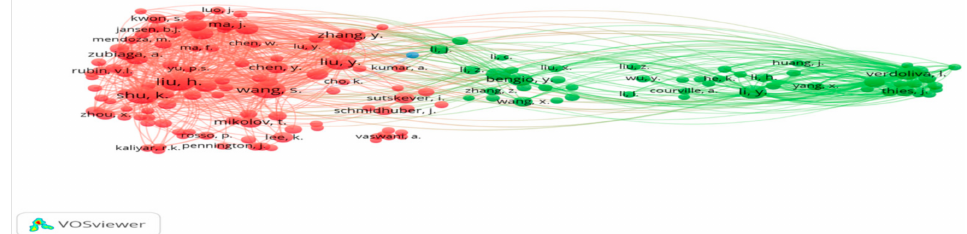
Figure 22. Co-citation